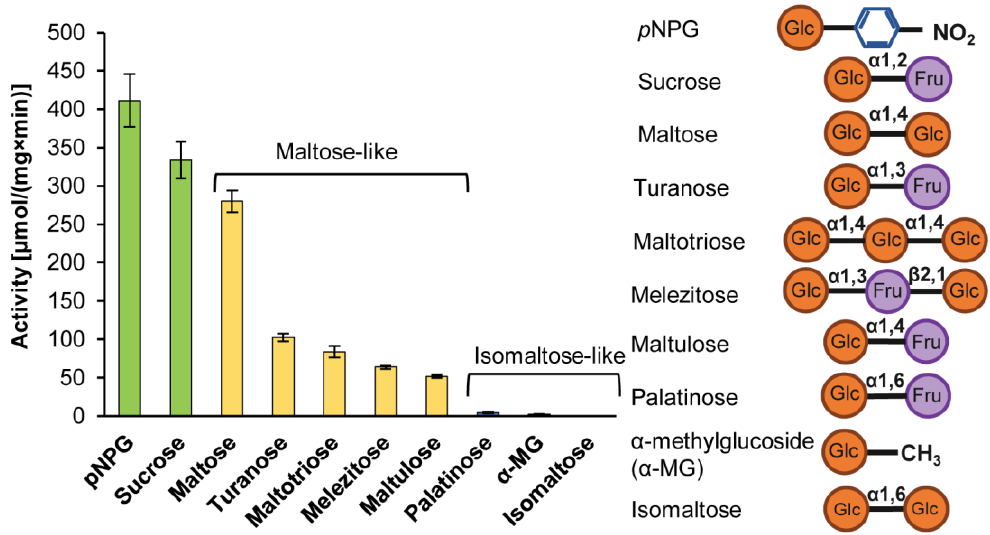
Figure 5. Activity of Ba AG2 on 100 mM sugars and 1 mM p NPG. Universal substrates are indicated by green, maltose and maltose-like sugars by yellow, and isomaltose and isomaltose-like sugars by blue bars. The composition and linkage types of the tested substrates are indicated. SD values of three to five replicates on each substrate are indicated.